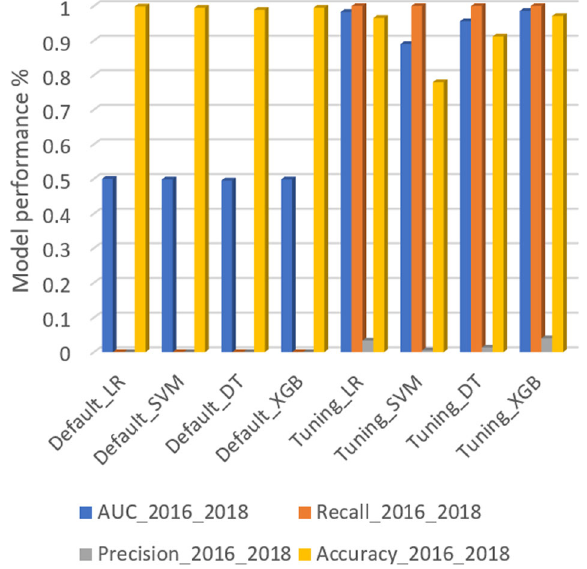
Fig. 3 Model performance for four different machine learning algorithms (including Extreme gradient boosting (XGB), Decision tree (DT), Logistic regression (LR), and Support vector machine (SVM)), with default and tuned parameters settings, using